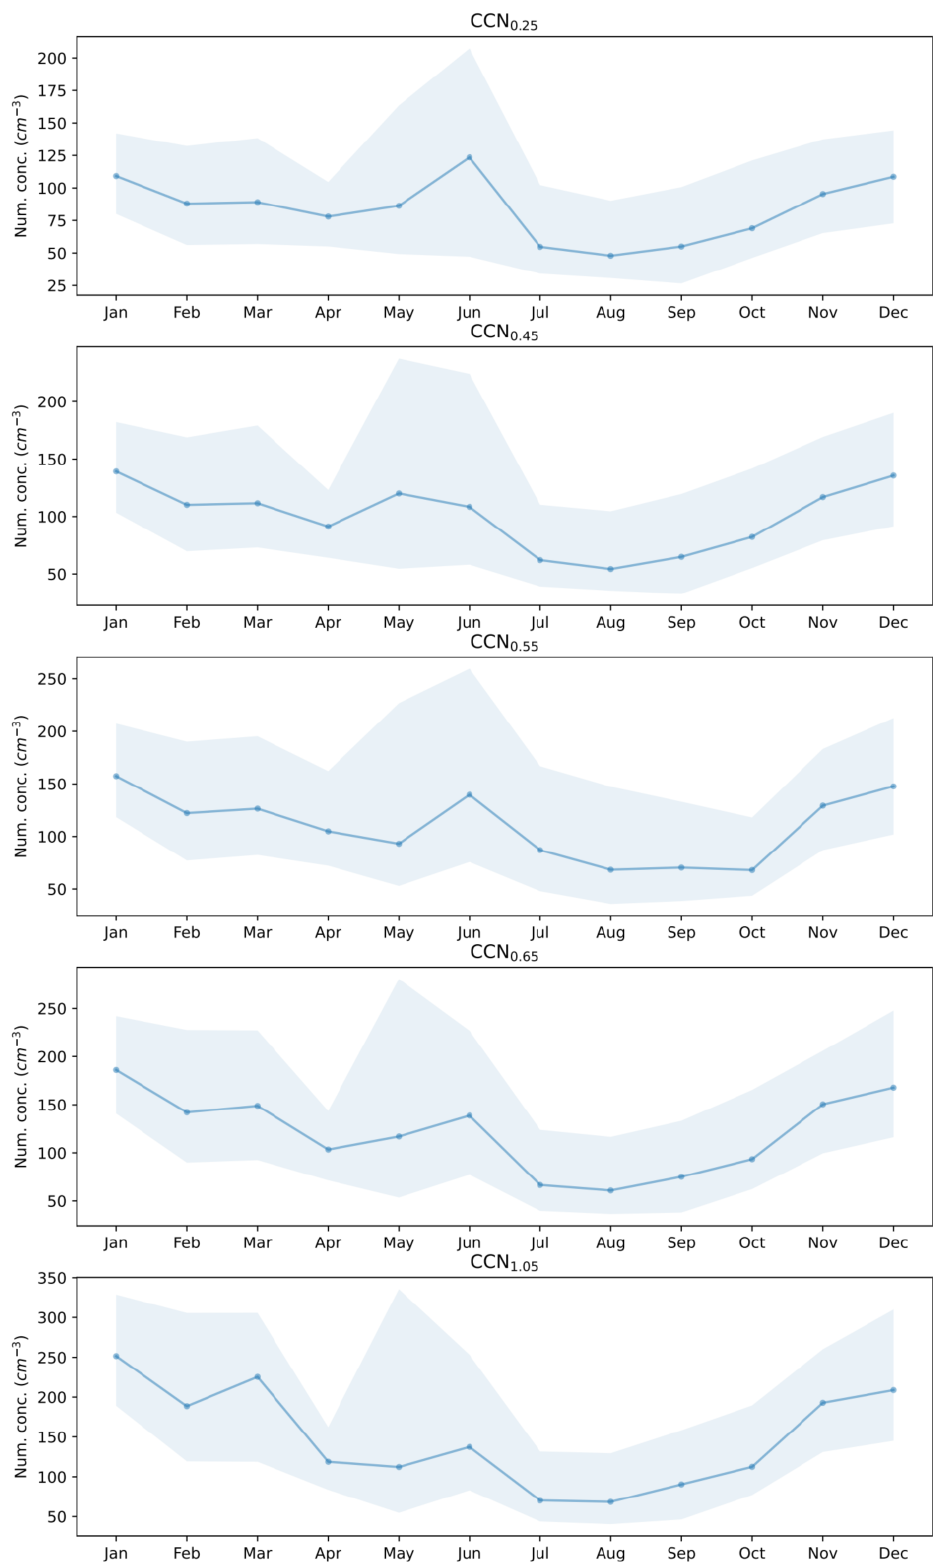
Figure A2. Annual cycles of CCN 0 . 5 at Macquarie Island for all five supersaturations measured.